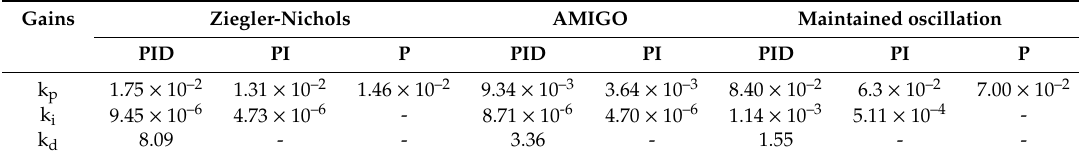
Figure 1. Controller tuning: ( a ) maintained oscillation method. Outlet H 2 S concentration versus time at several proportional gains; ( b ) step-response method (Ziegler-Nichols rules (ZN)). Inlet and outlet H 2 S concentration versus time. Table 3. Gains for step-response and maintained oscillation methods.